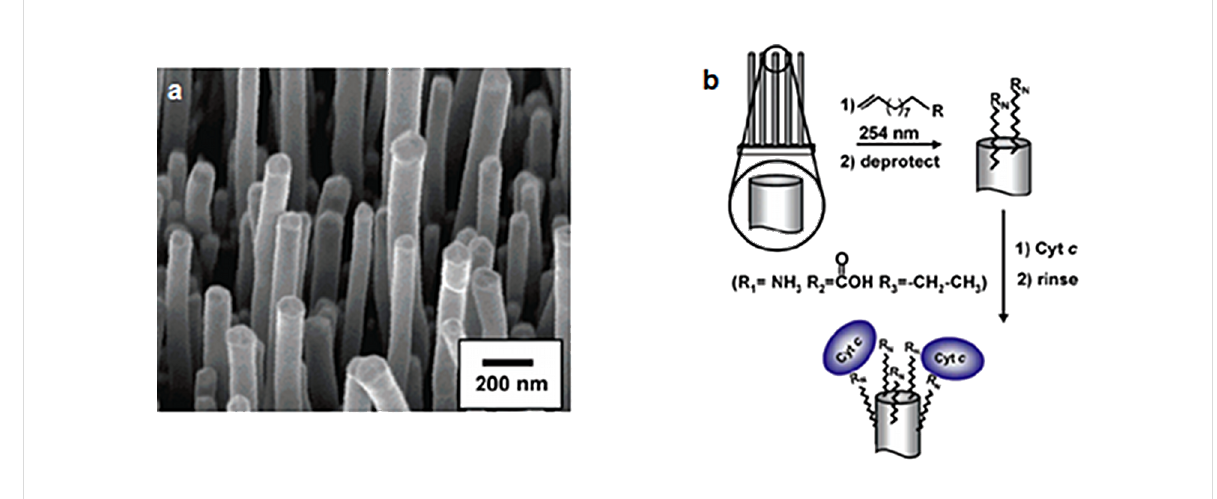
Figure 23: (a) SEM image (taken at a 25° tilt) of a VA-CNFs substrate. (b) Schematic of the functionalization of VA-CNFs with the redox-active protein Cytochrome c . Adapted with permission from [169]. Copyright 2006 American Chemical